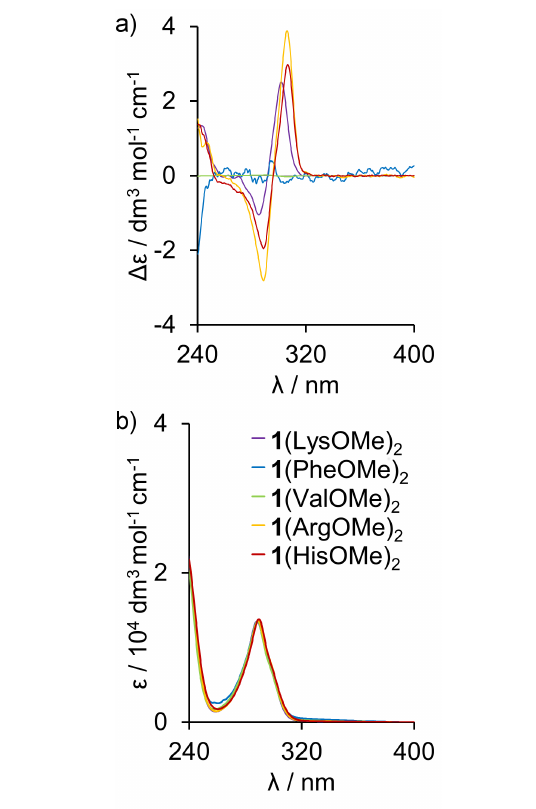
Figure 3: CD (a) and UV (b) spectra of complexes [ 1 (LysOMe) 2 ], [ 1 (PheOMe) 2 ], [ 1 (ValOMe) 2 ], [ 1 (ArgOMe) 2 ], and [ 1 (HisOMe) 2 ].